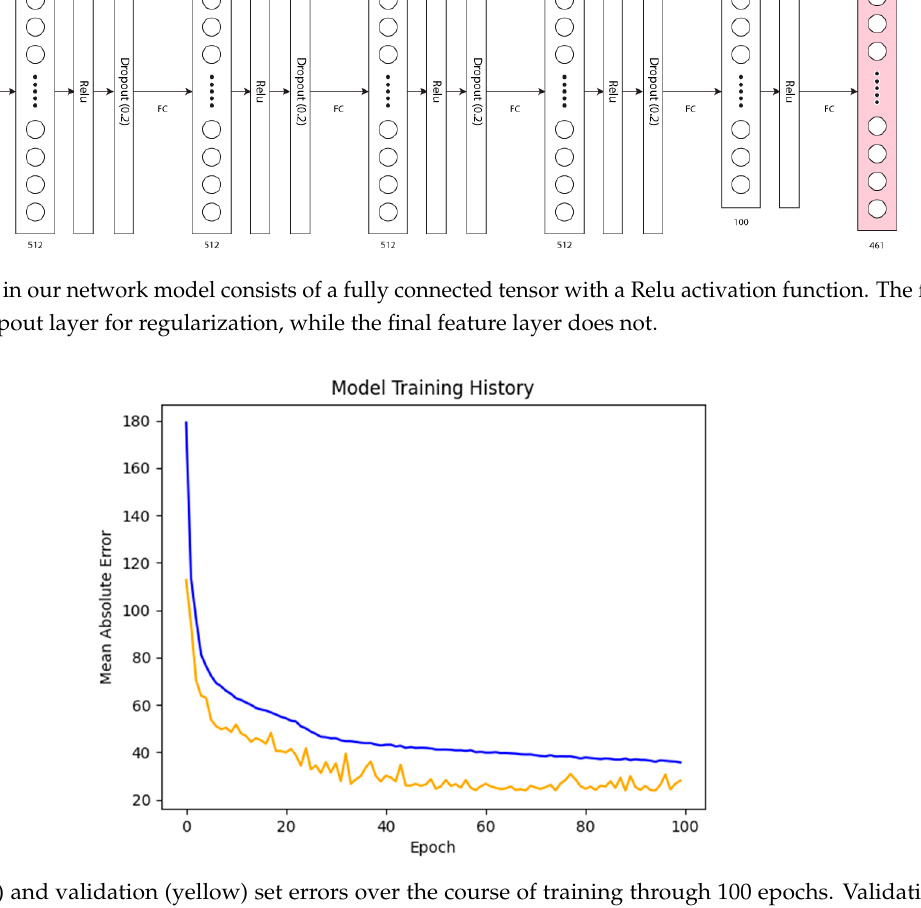
Figure 5. Test (blue) and validation (yellow) set errors over the course of training through 100 epochs. Validation error seems to level off around 50 epochs in.